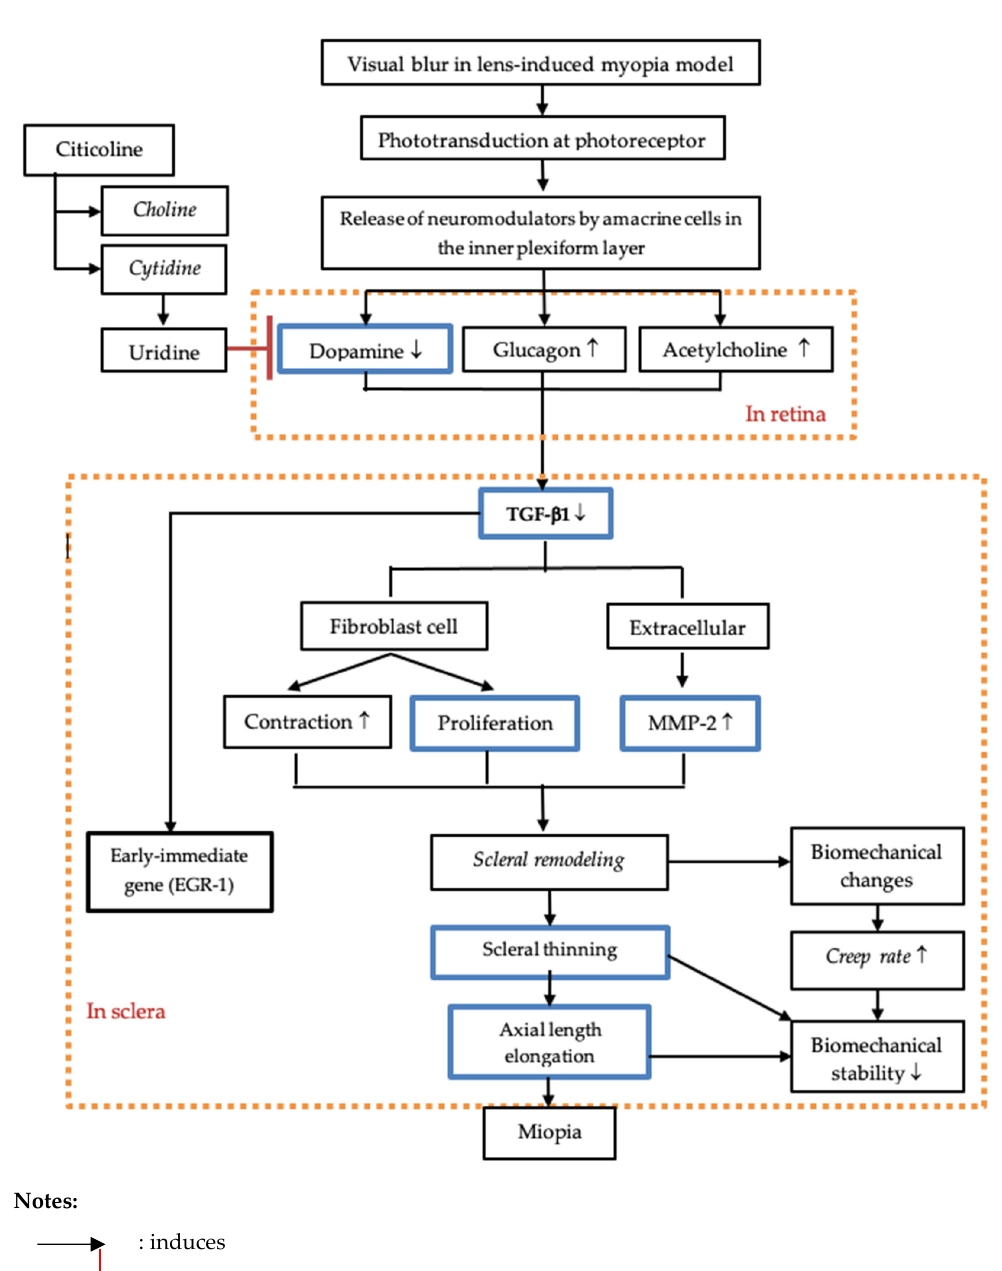
Figure 7. A schematic diagram of general pathway that may be important in the control of eye growth and how citicoline effects the scleral tissue. The first stage of growth signal cascades requires the linking of photoreceptors and dopaminergic amacrine cells inside the inner retina. Reduced stimulation of photoreceptors in LIM model decreases input to the dopaminergic amacrine cells [33]. The release of neurotransmitters by the retinal amacrine cells will convey a signal to the choroid and to the sclera [14–16]. The process of scleral remodeling is the final stage of adaptation of the sclera to an eye with myopia. The cytokine TGF- β plays an important role in regulating changes in the extracellular matrix of the sclera. A low TGF- β concentration results in decreased collagen and proteoglycan synthesis, thereby weakening the scleral extracellular matrix’s biomechanical proper- ties. This causes the expression of α smooth muscle actin on fibroblasts, thus causing differentiation of fibroblasts into myofibroblasts [23]. The balance of MMP-2 expression seems to have important roles in the metabolism of extracellular matrix in the sclera [20,21]. Under LIM conditions, there was an increase in free proenzyme MMP-2 activated along with a decrease in tissue inhibitor of